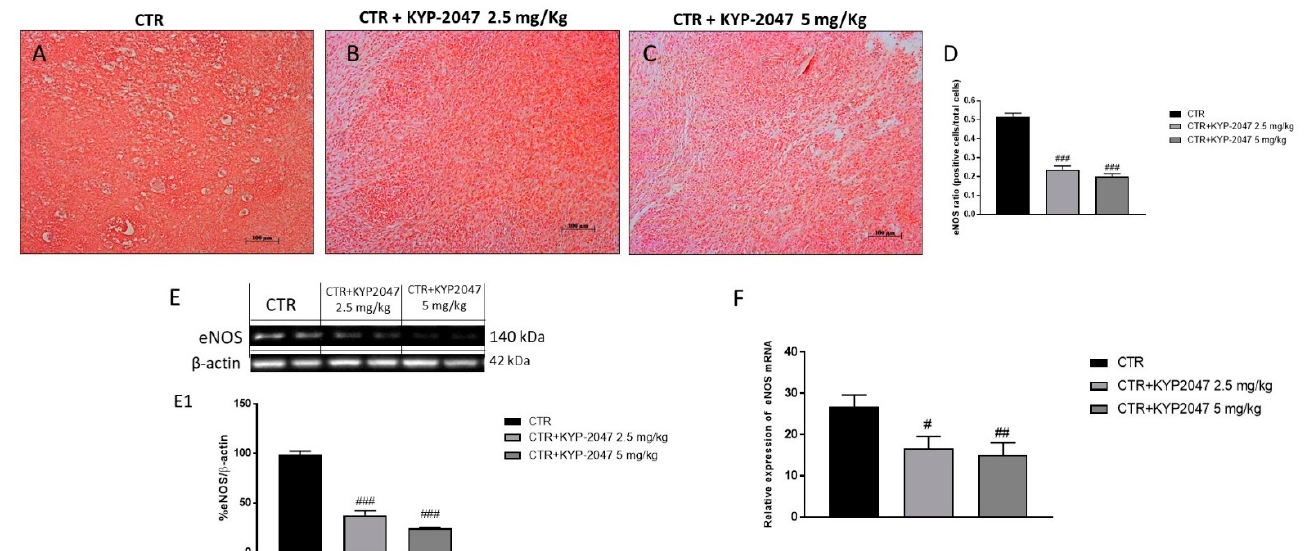
Figure 3. Effect of KYP-2047 on endothelial-nitric-oxide synthase (eNOS) expression. Immunohistochemical staining showed a marked expression of eNOS in the control group ( A ) whereas the treatment with KYP-2047 at doses of 2.5 mg/kg and 5 mg/kg significantly reduced its expression ( B , C ). Sections were observed and photographed at 10× magnification. The data were confirmed by Western blot analysis and RT-qPCR, showing a decrease of eNOS expression following KYP-2047 treatment ( E , F ). Data are representative of at least three independent experiments. ( D ) ### p < 0.001 vs. CTR; ( E ) ### p < 0.001 vs. CTR. ( F ) # p < 0.05 vs CTR; ## p < 0.01 vs. CTR.